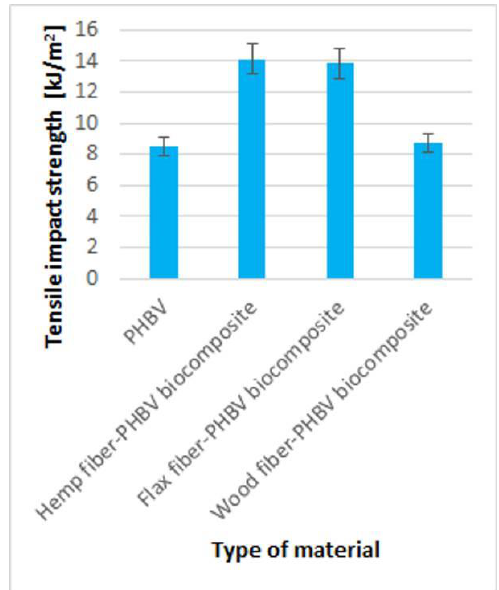
Figure 8. The results of tensile impact strength test for pure polymers and biocomposites with various fillers type .